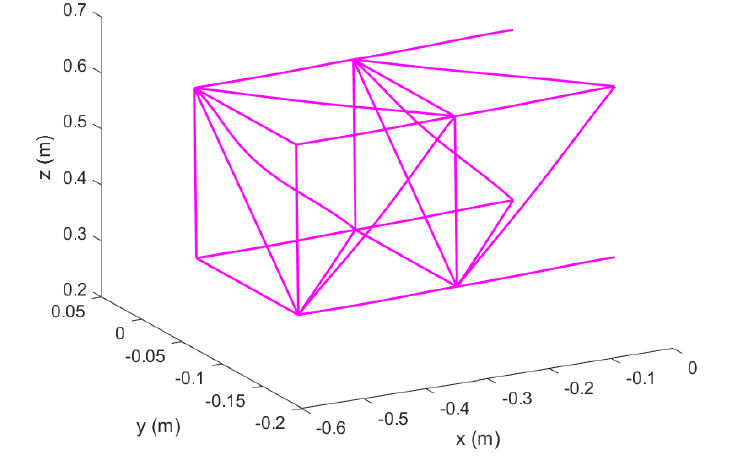
Figure 13. Mode 3 of Euler–Bernoulli Beams in Topology 1 with no hinged ends; original configuration.